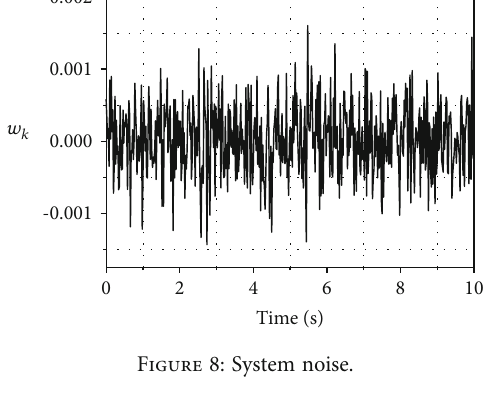
Figure 8: System noise.